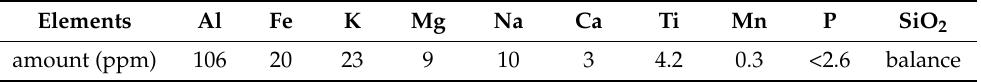
Table 1. Chemical composition of natural quartz analyzed by inductively coupled plasma–optical emission spectrometry (ICP-OES) (the analysis was performed by Jusnes [45]).